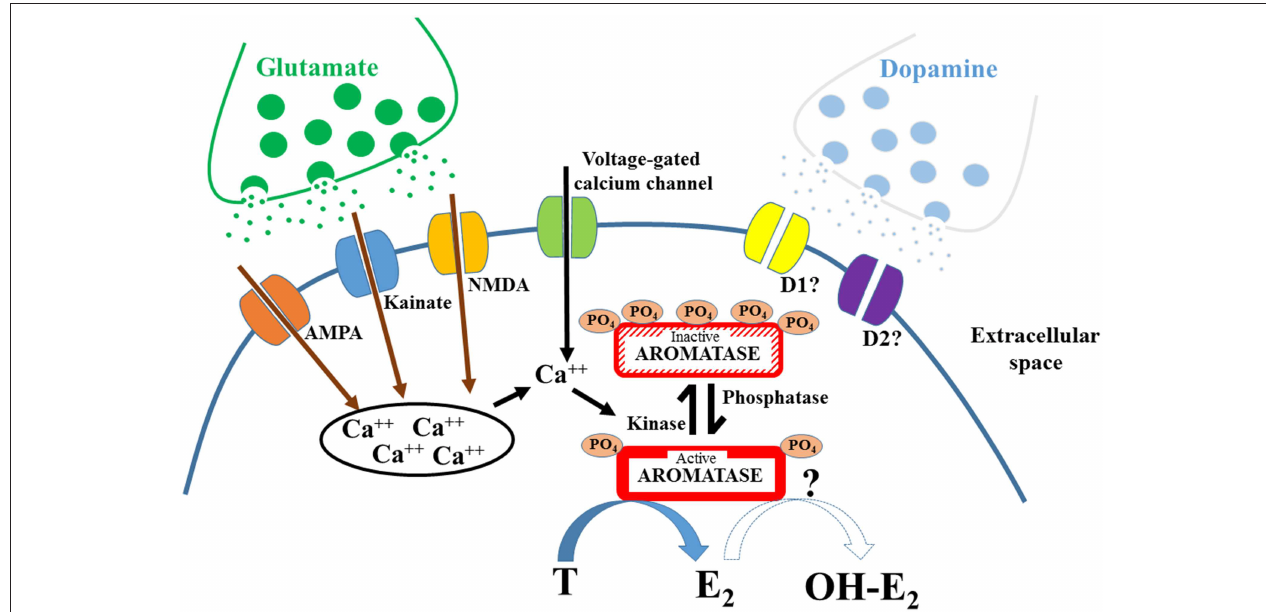
glutamatergic receptors and/or by dopaminergic receptors. The increase of intracellular calcium (Ca ++ ), either from intracellular storage or from the activation of voltage-gated channel is in most cases a prerequisite for the inhibition of aromatase activity. Change in phosphorylation level could also affect the hydroxylase activity of